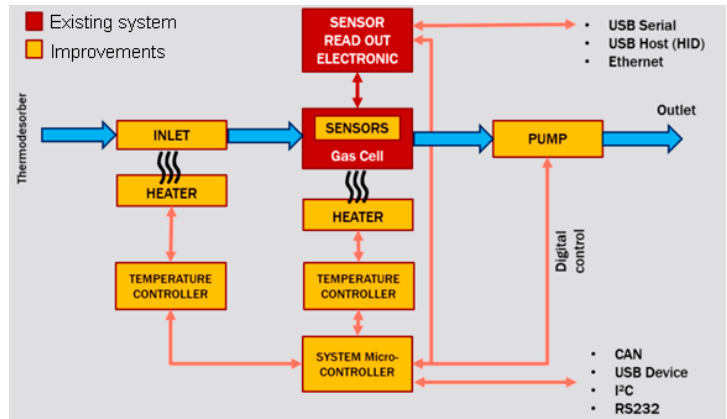
Figure 1. Global architecture of gas analysis system based on MEMS sensors. In this work, the existing system must be adapted to container inspection applications. In this case, sensors have been optimized and heaters are now necessary to adapt the system and the sampler method (thermodesorption).